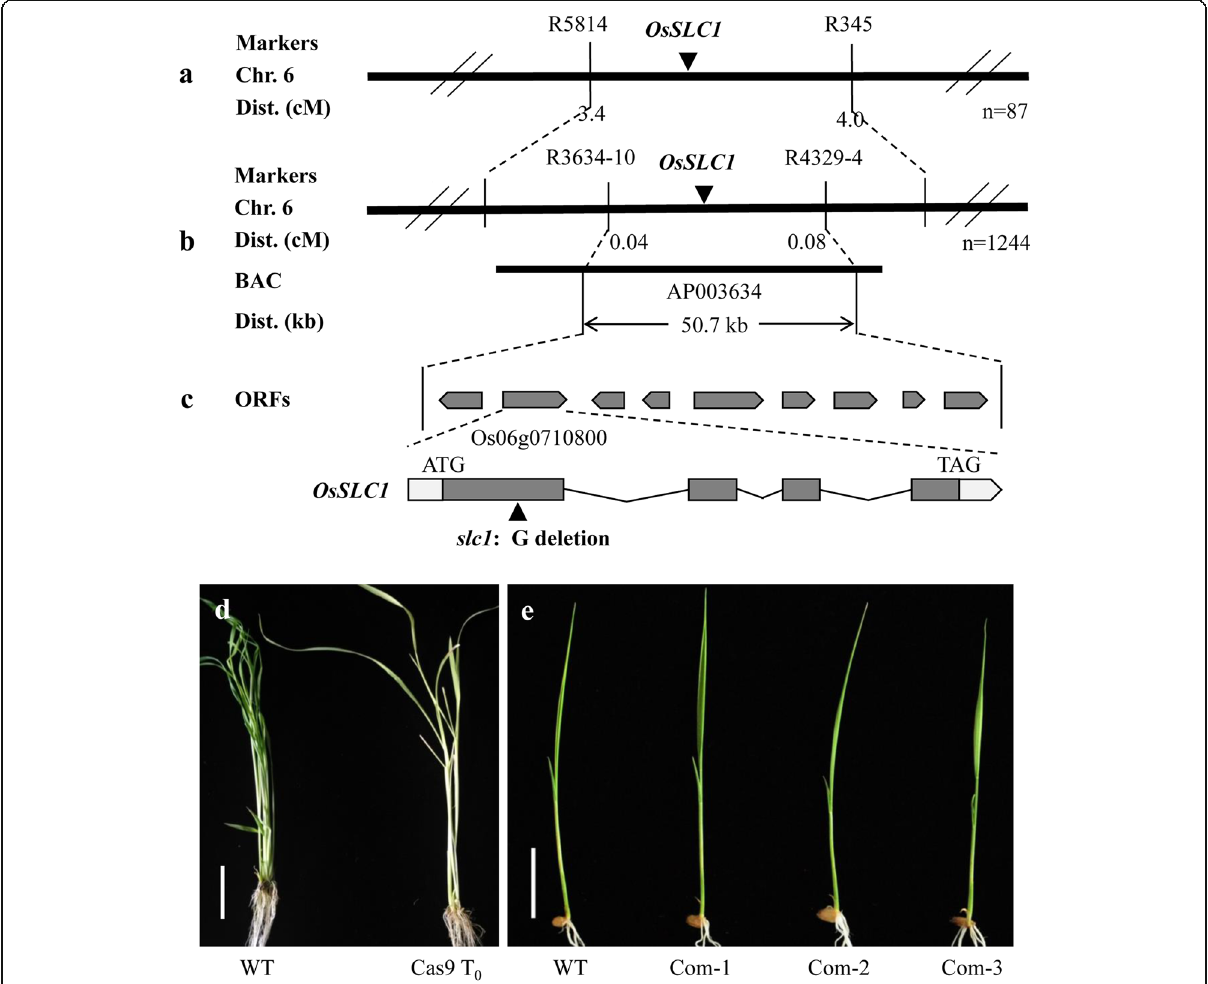
Fig. 3 Map-based cloning of OsSLC1 . a The OsSLC1 locus was mapped to chromosome 6 (Chr. 6). b The OsSLC1 locus was fine-mapped to a 50.7 kb interval on the BAC clone AP003634. c Open reading frame of the candidate gene Os06g0710800 in the mapped region; the mutation site is indicated by a black upright triangle. d T 0 mutant generated using the CRISPR/Cas9 system. e Independent T 1 complementation plants. WT, wild type. Scale bars, 2